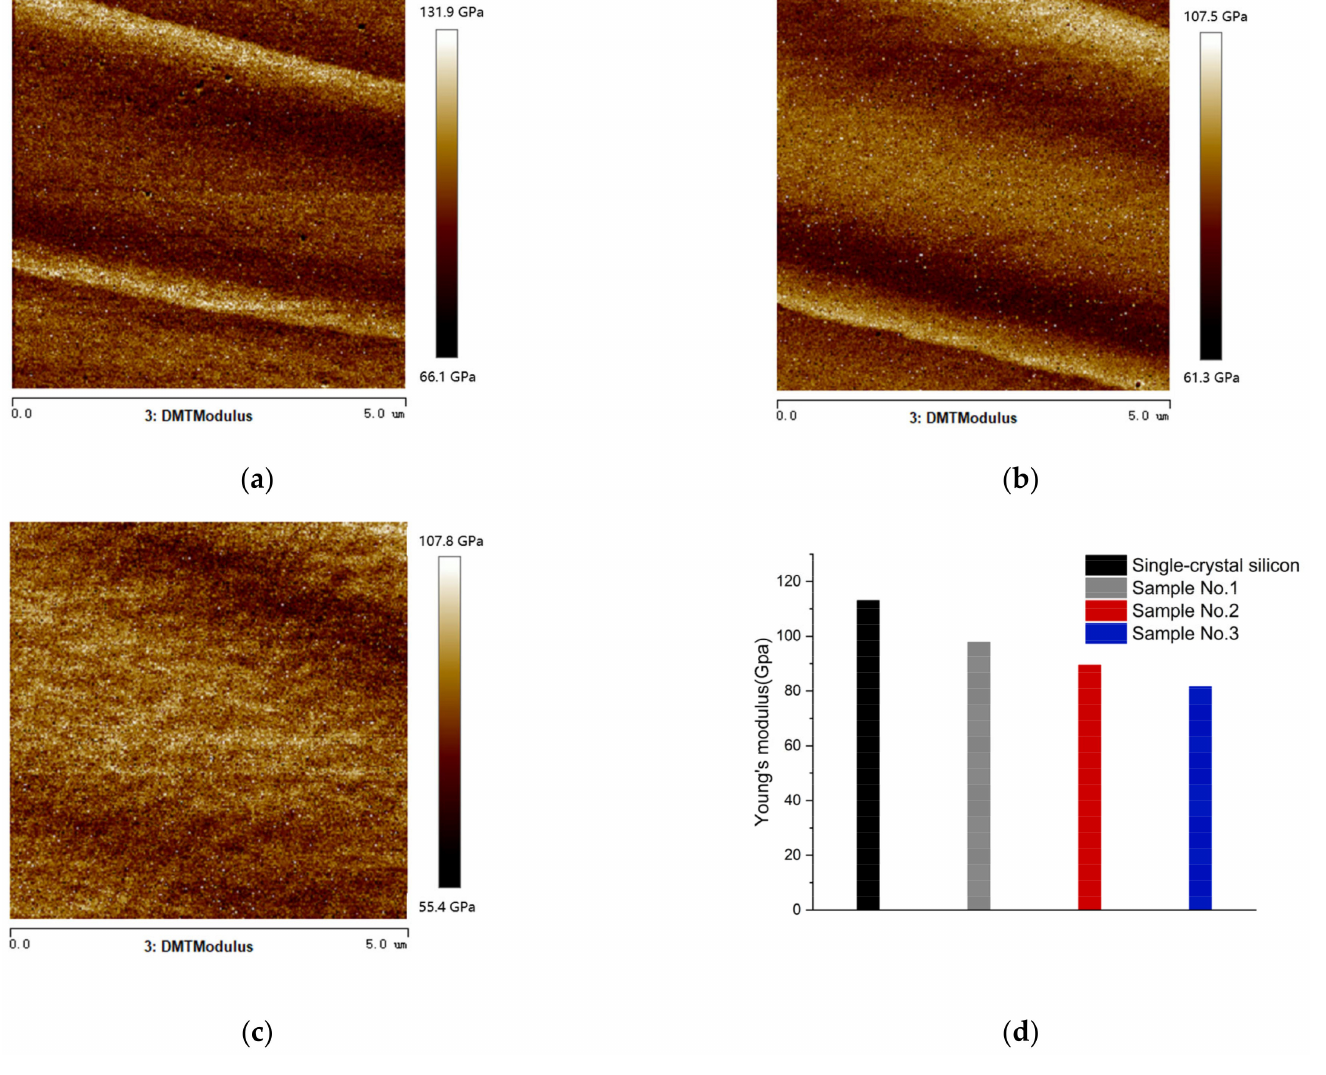
Figure 8. Young’s modulus test results: The Young’s modulus image of sample ( a ) No. 1; ( b ) No. 2; ( c ) No. 3; ( d ) average values of Young’s modulus of different